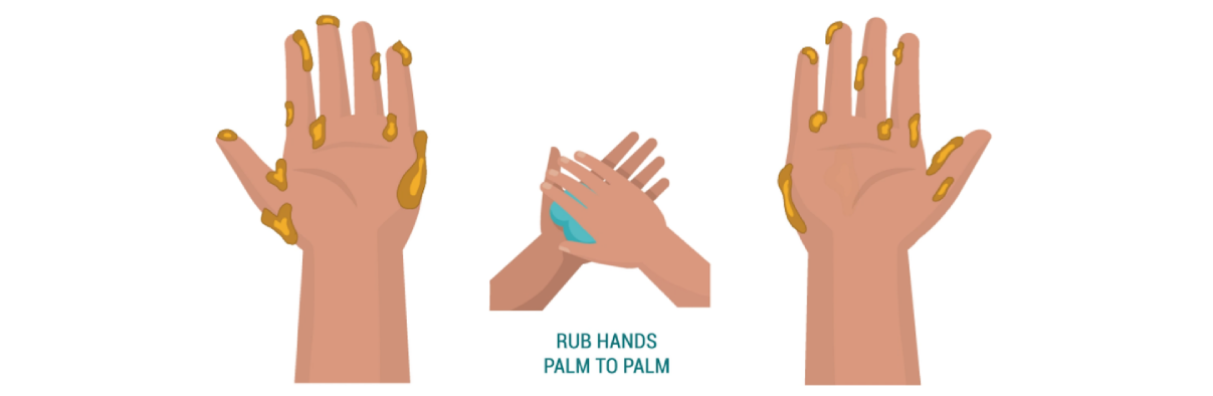
Figure 5. Reinforcement condition.